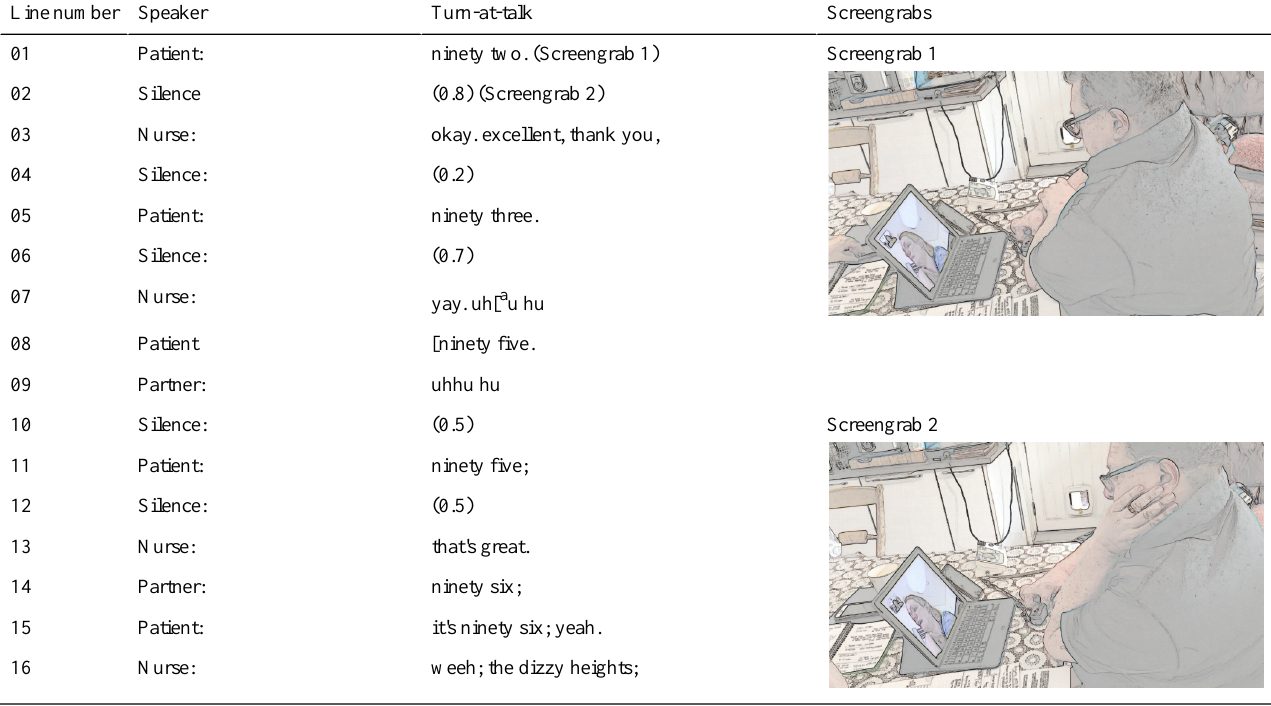
Table 1. Example of a patient reporting oxygen saturation readings (data recorded at the patient end). ScreengrabsTurn-at-talkSpeakerLine